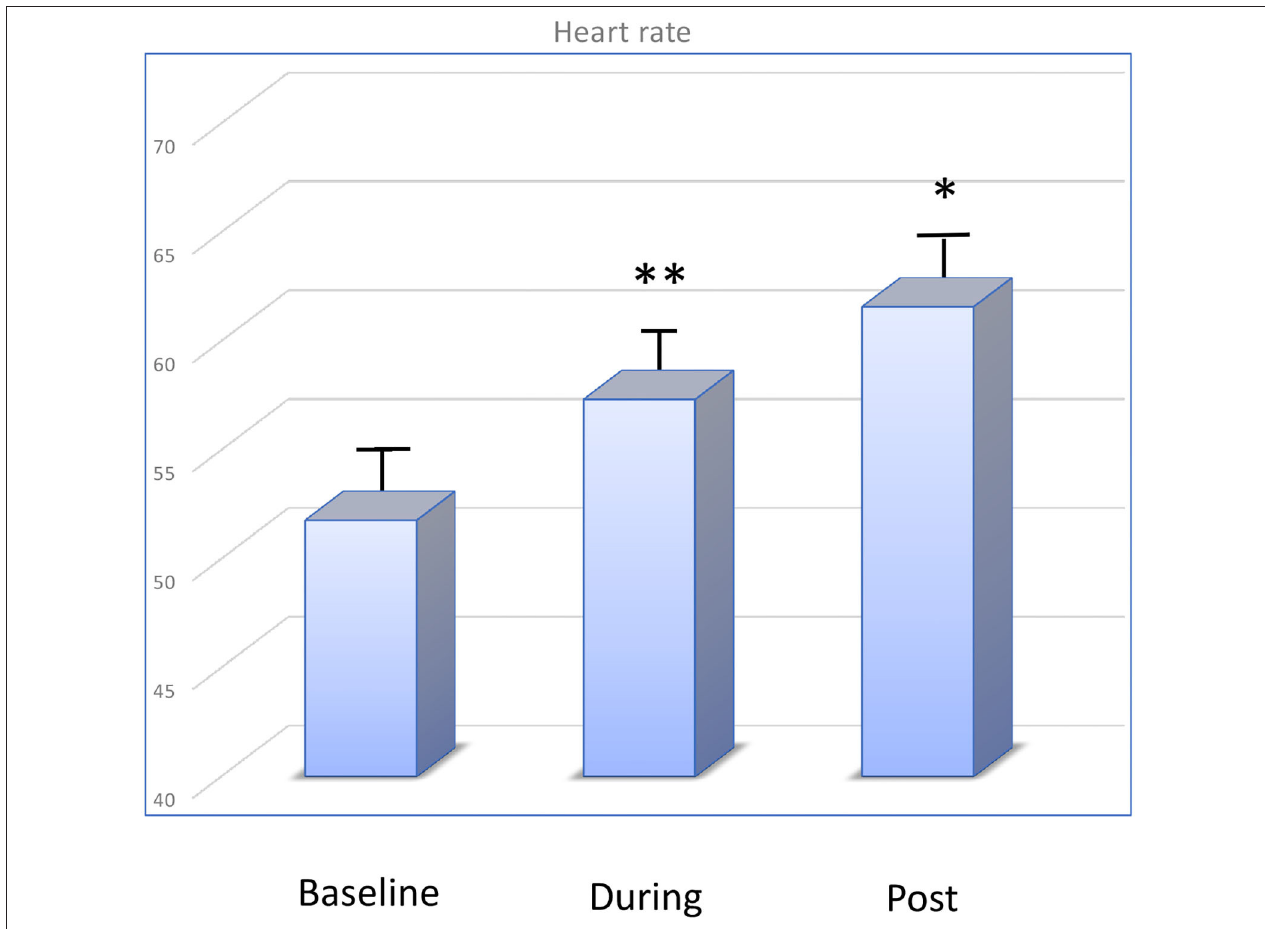
FIGURE 1 | Changes in heart rate (bpm) at baseline, during, and after